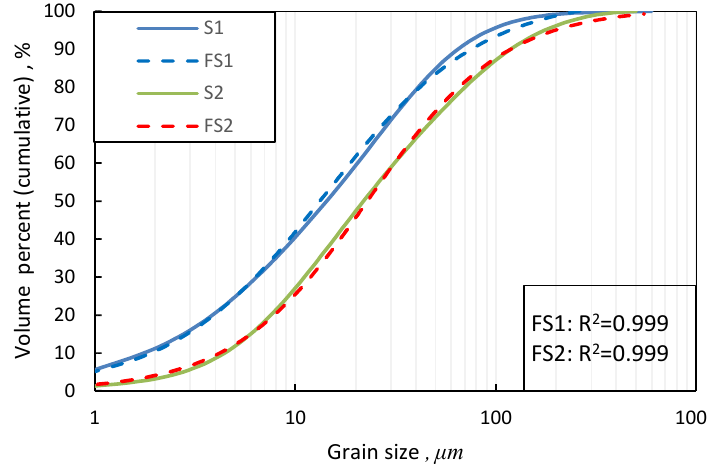
Figure 7. Comparison between modeled PSD curve and measured PSD curve.